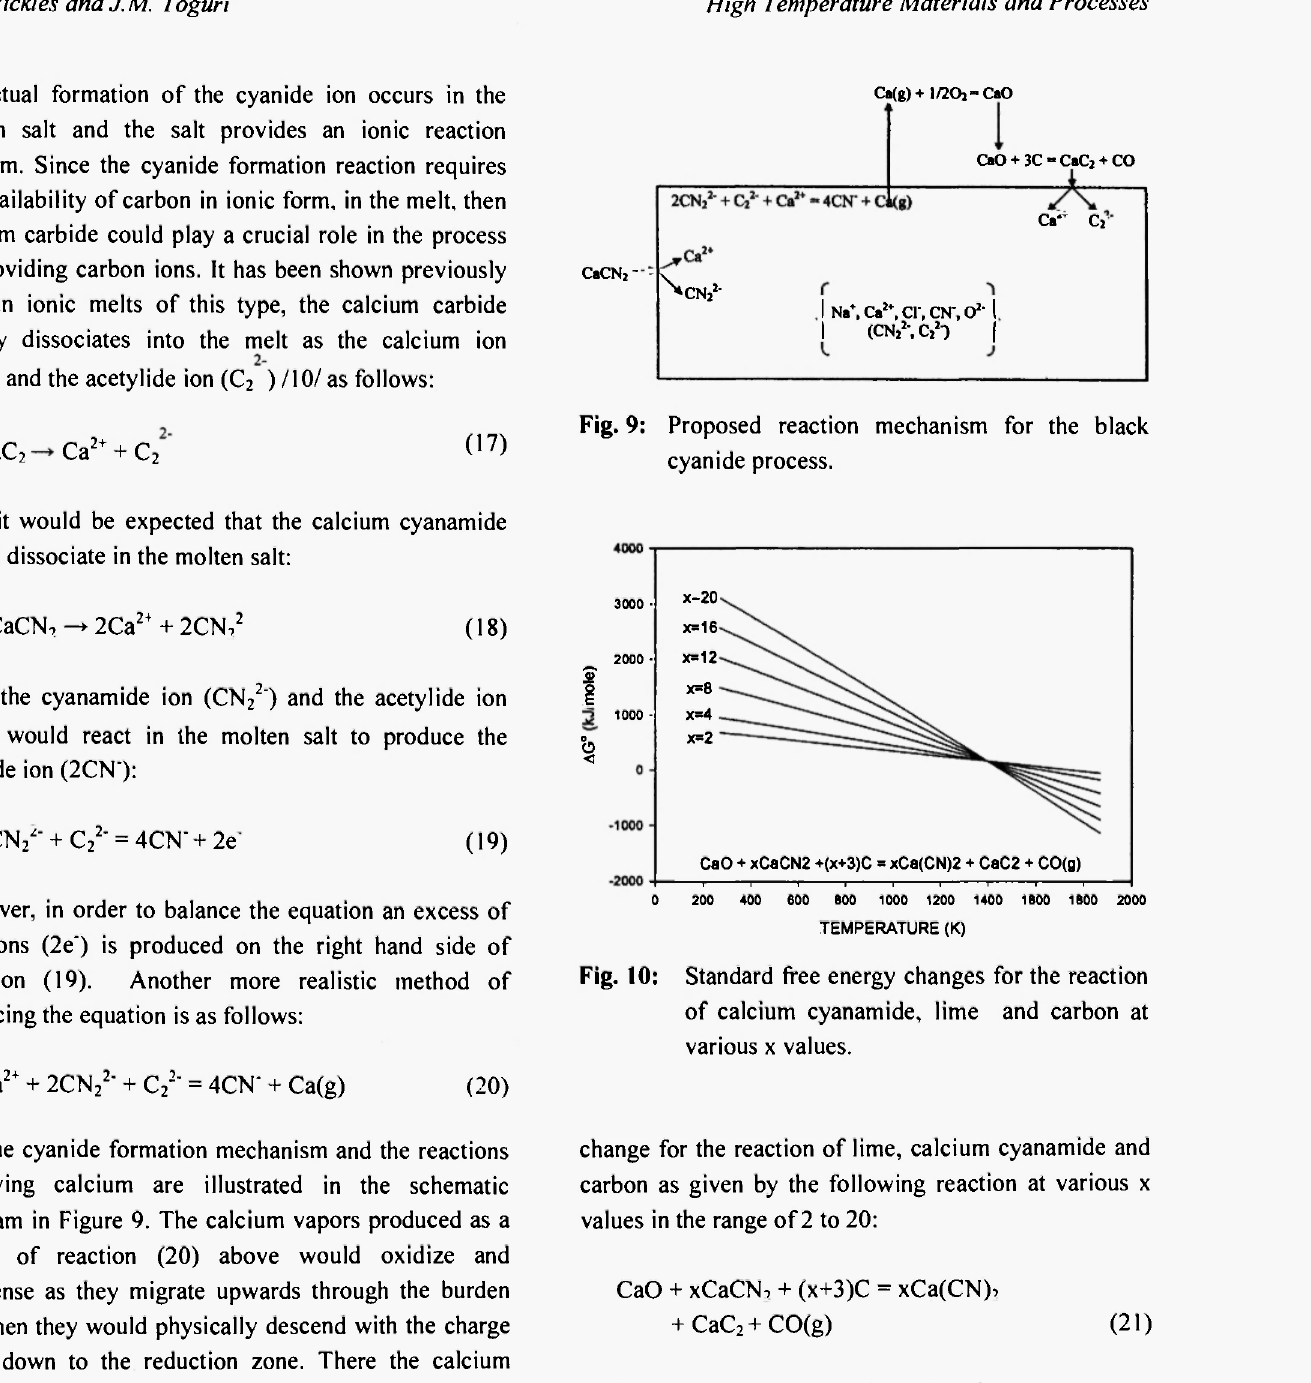
Fig. 10: Standard free energy changes for the reaction of calcium cyanamide, lime and carbon at various χ